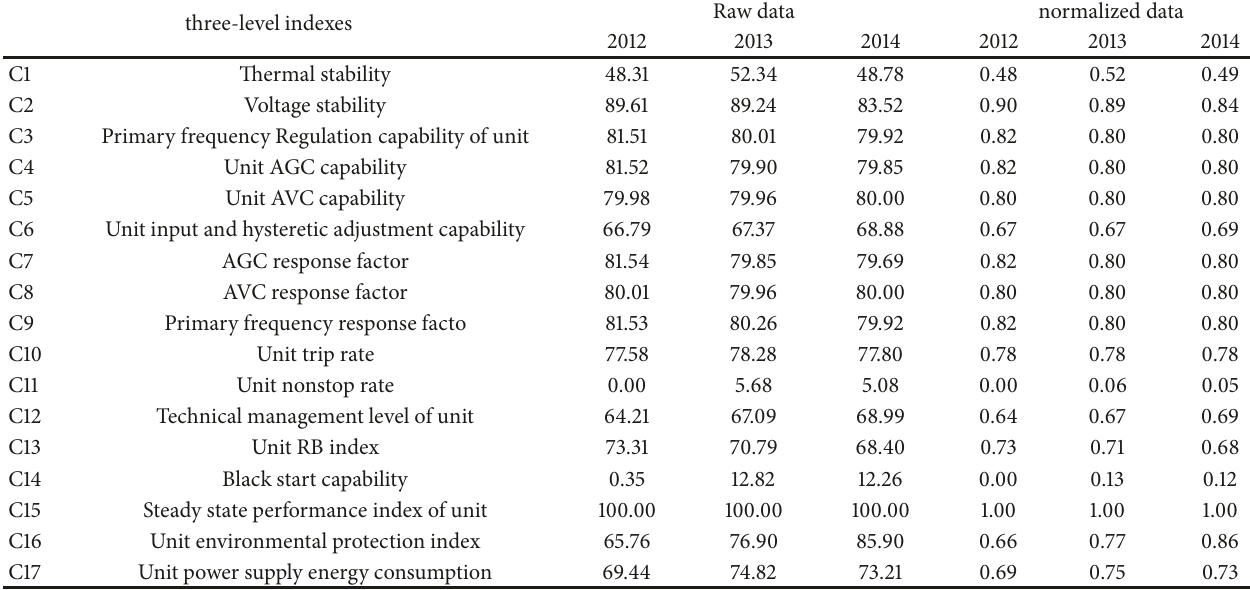
Table 1: Example data.